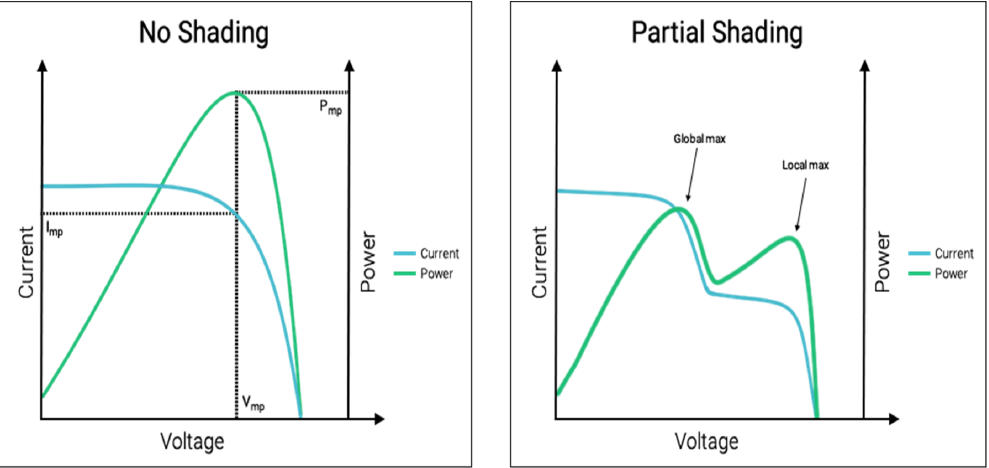
Figure 15. Maximum power point tracking results under various conditions, such as no shading and partial shading.